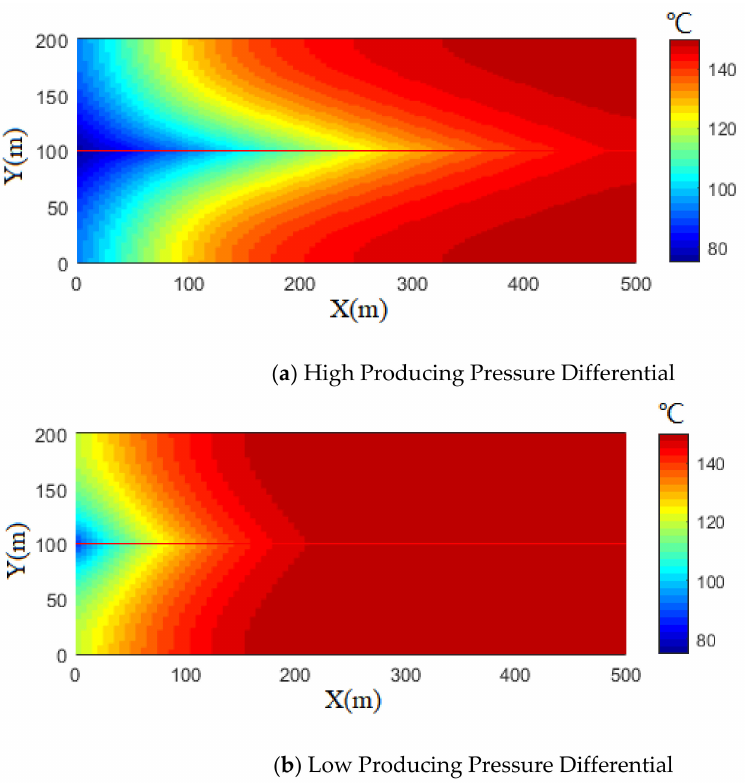
Figure 5. Thermal front comparison between high and low producing pressure differential. Com- pared with ( a , b ), the high producing pressure differential makes the thermal front spread quicker than that in the matrix.